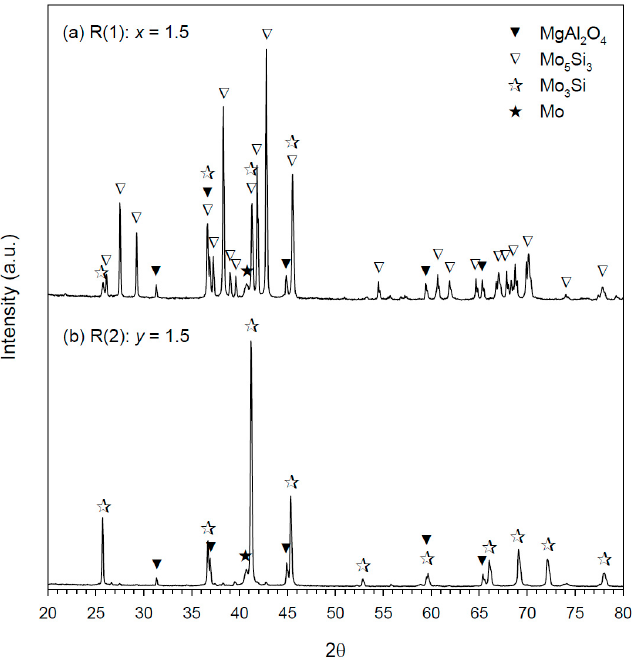
Figure 5. X-ray di ff raction (XRD) patterns of Mo 5 Si 3 –MgAl 2 O 4 and Mo 3 Si–MgAl 2 O 4 composites Figure 5. X-ray diffraction ( XRD) patterns of Mo 5 Si 3 –MgAl 2 O 4 and Mo 3 Si–MgAl 2 O 4 composites synthesized from ( a ) R(1): x = 1.5 and ( b ) R(2): y = synthesized from ( a ) R(1): x = 1.5 and ( b ) R(2): y = 1.5.